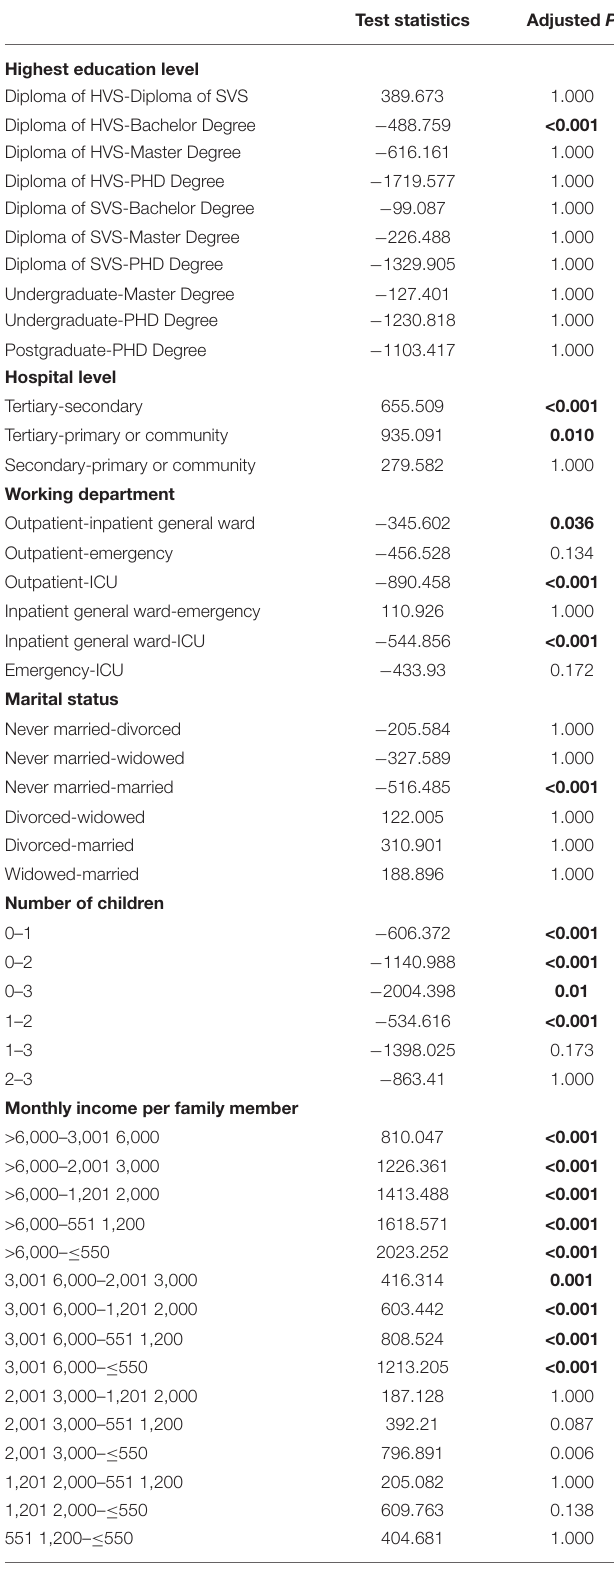
TABLE 2 | The outcome of pairwise comparison in different demographic